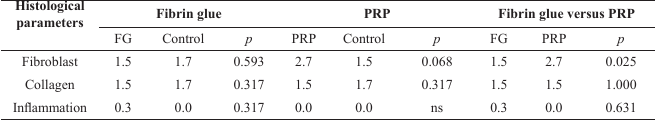
TABLE 4 - Average scores for the histological analysis on grafts within seven to 14